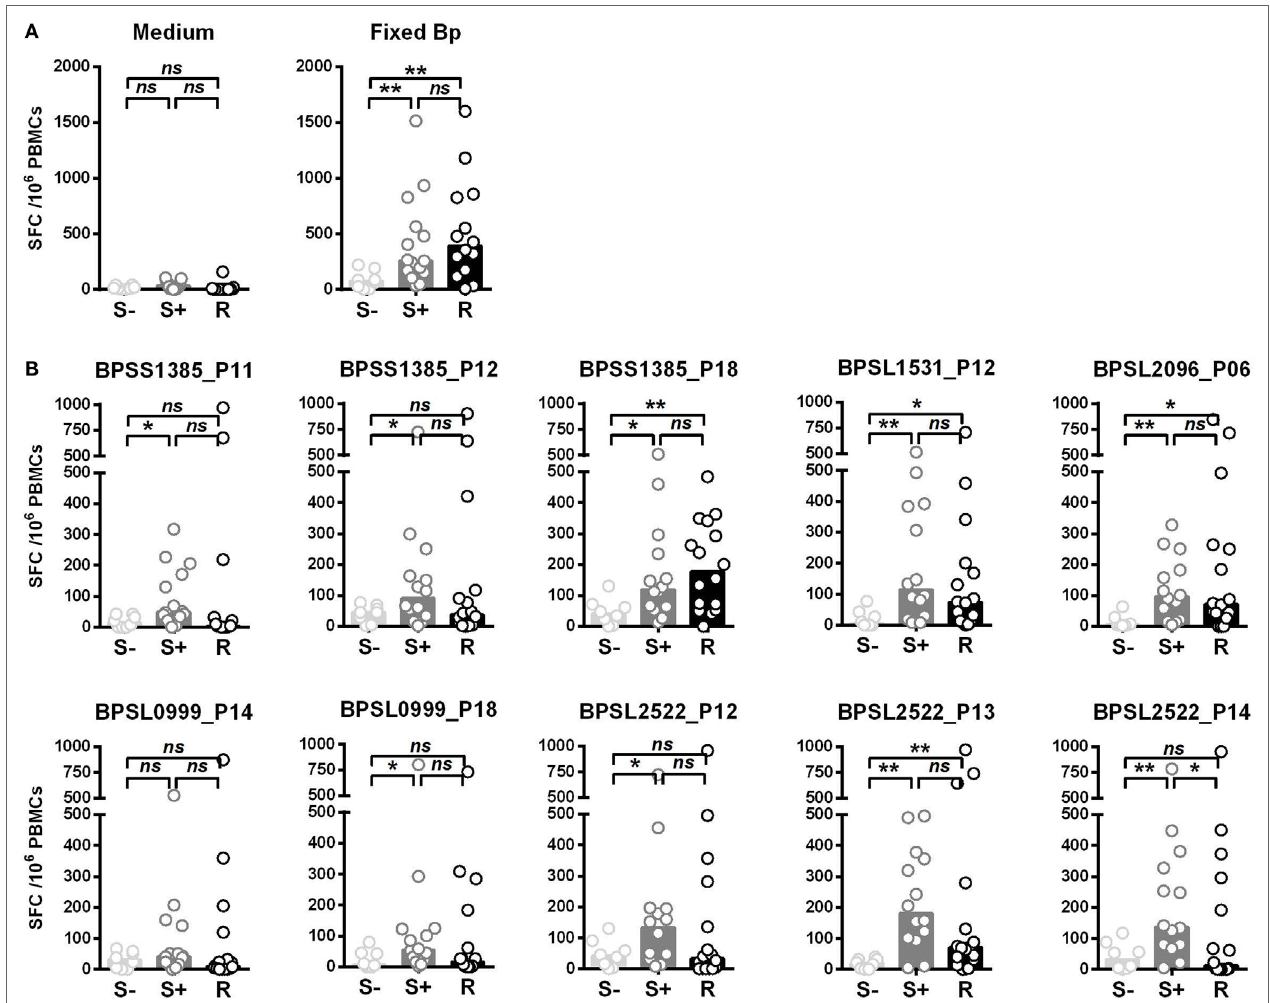
FigUre 2 | Differential IFN γ responses to 10 Burkholderia pseudomallei (Bp) immunoprevalent peptides in individuals that are seronegative for Bp, seropositive for Bp, or have recovered from acute melioidosis. Peripheral mononuclear cells (PBMCs) from seronegative (S − , n = 8), seropositive (S + , n = 15), and individuals that have recovered from melioidosis (R, n = 15) were cultured with medium only control or paraformaldehyde (PFA) fixed Bp (a) , or the top 10 immunoprevalent peptides (B) . Horizontal lines represent mean value for each group. Statistical significance was determined using Mann–Whitney U test; ns, not significant, * p < 0.05 and ** p <